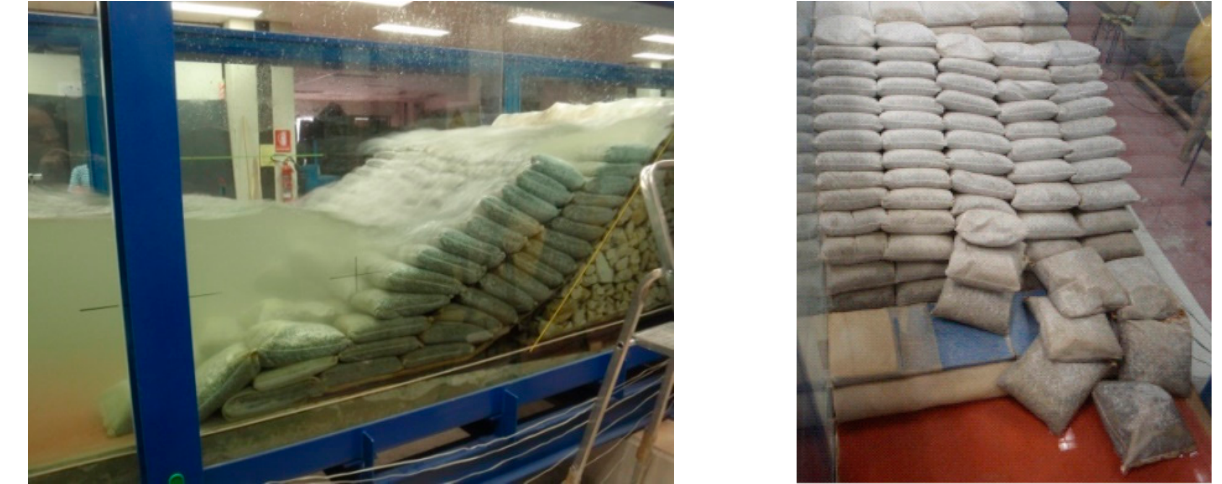
Figure 18. Configuration with slope 1:1. Instability of the structure in the stability test with H = 0.20 m, T = 2.0 s and h = 0.61 m.